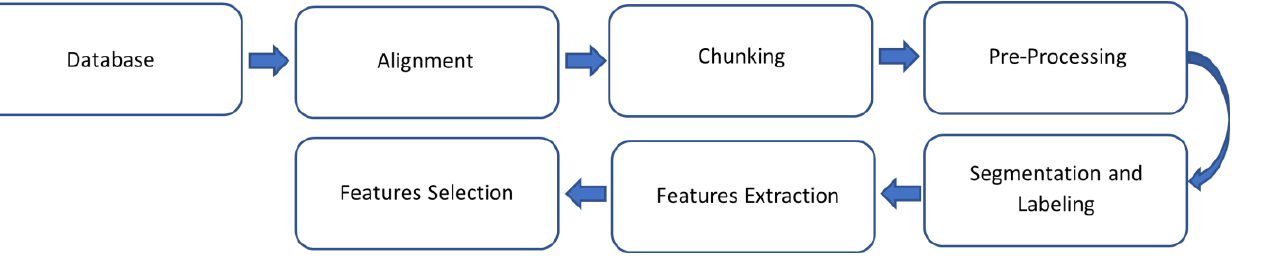
Figure 1. Workflow of data analysis.